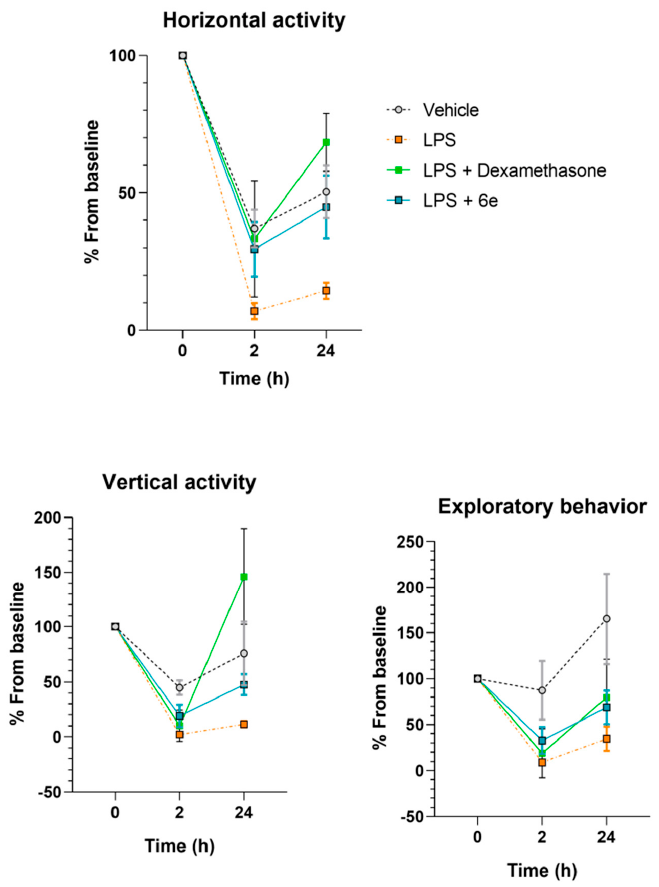
Figure 2. Motor activity of mice in the open field test. Data are shown as mean ± SD.